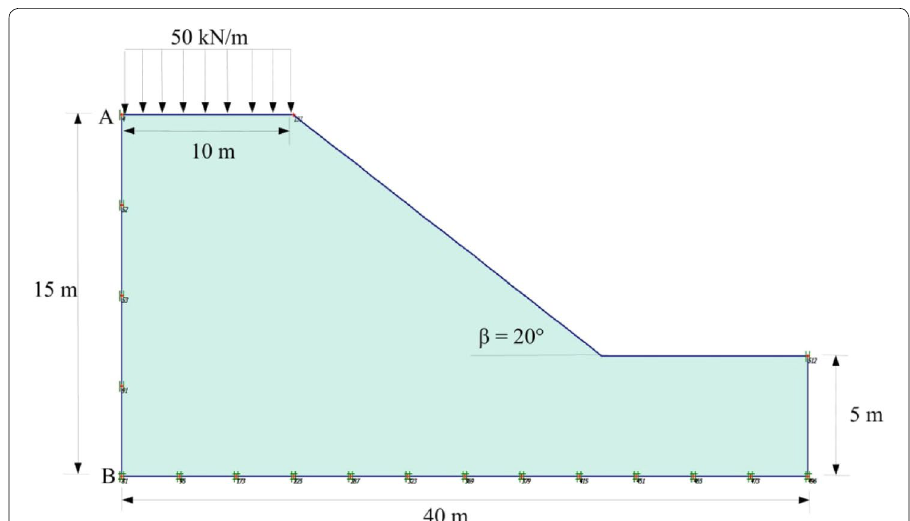
Fig. 10 Plot of geometry with loads and boundary conditions (all dimension are in